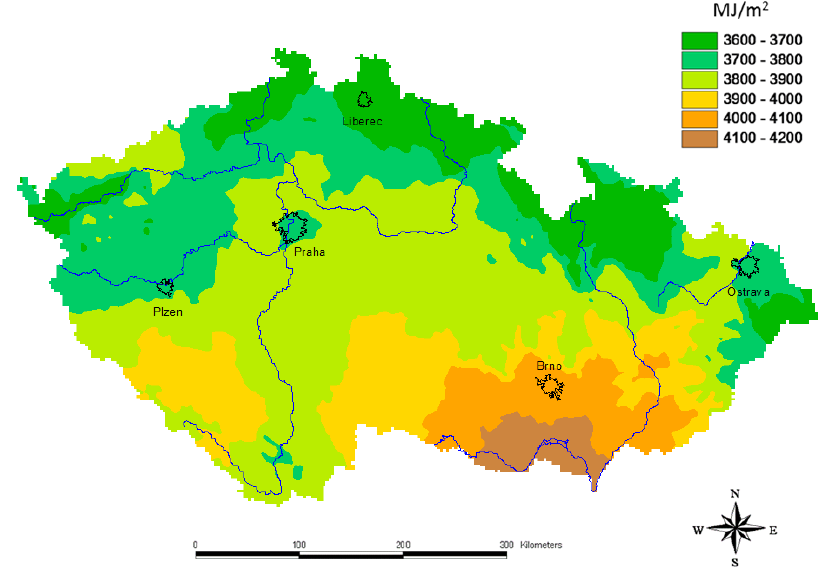
Figure 4. Long-term average of the annual sum of SIS constructed by the combination of measured and CMSAF data